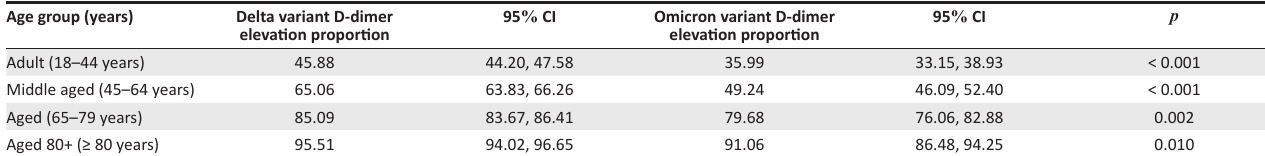
IQR, interquartile range. TABLE 2: Proportion of elevated D-dimer results per variant binarised according to test thresholds and sub-grouped by patient age group.